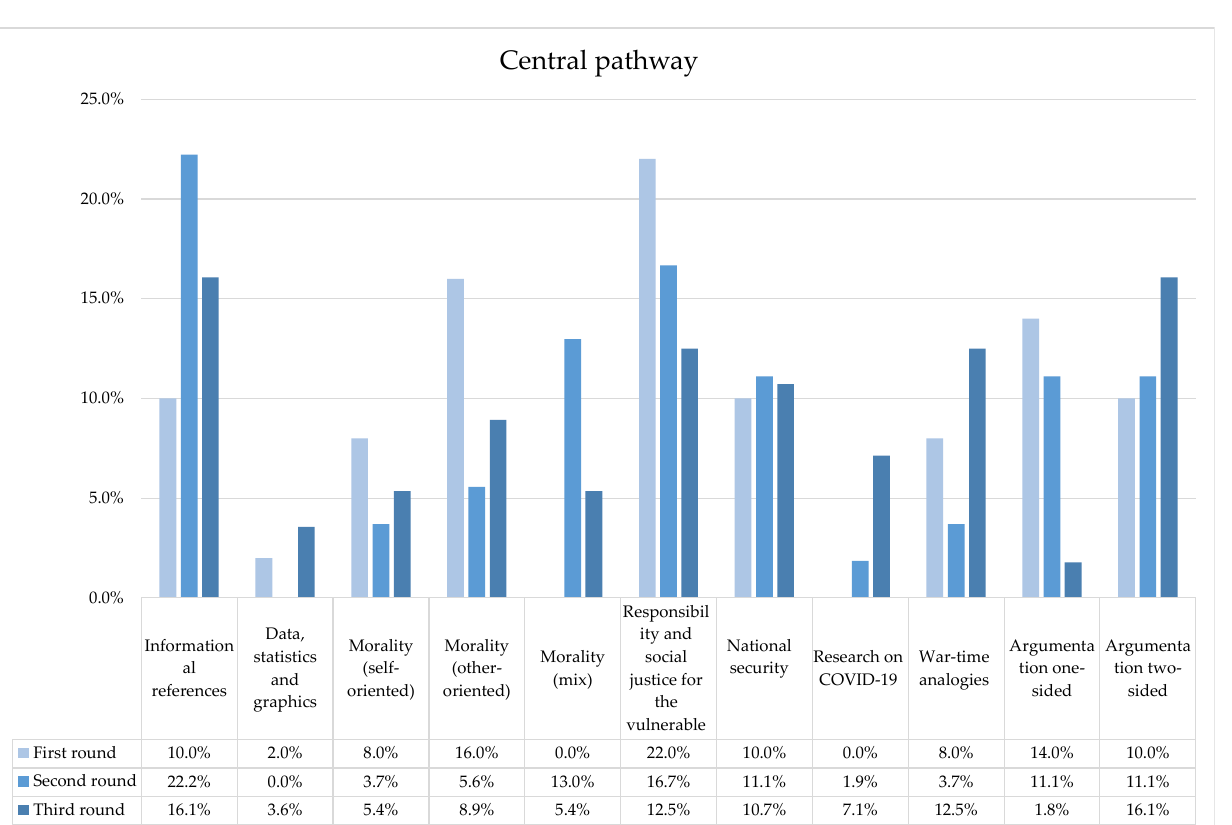
Figure 2. Percentage distribution of spots for each central cue across the three phases of the Italian institutional health campaign during COVID-19 pandemic.